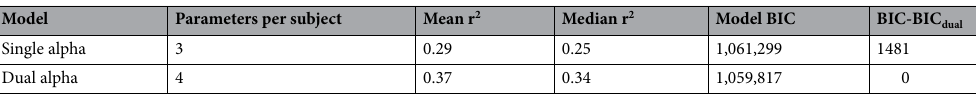
Table 3. Model Comparison for individual plays. Bayesian information criterion (BIC) measures are summed for fits for each participant’s first play (N = 26,720). Both models included choice stochasticity (inverse temperature) and loss aversion parameters. The final column is the difference between the model BIC and BIC for the Dual Alpha model.